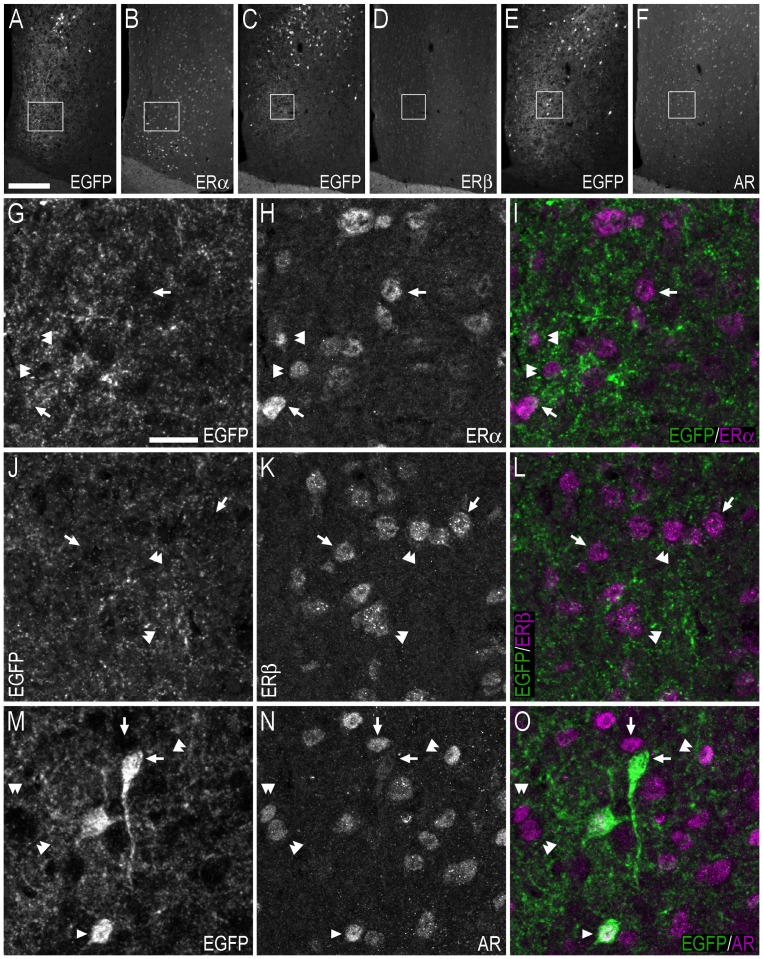
Double-immunofluorescence photo and confocal micrographs showing the distribution of EGFP-, ERα−, ERβ-, and AR-LI at the level of the medial preoptic nucleus/area.(A, B) Single-channel photomicrographs of double-fluorescence immunohistochemistry, showing EGFP− (A) and ERα-LI (B) (Bregma, −0.22 mm). (C, D) Single-channel photomicrographs of double-fluorescence immunohistochemistry, showing EGFP− (C) and ERβ-LI (D) (Bregma, −0.34 mm). (E, F) Single-channel photomicrographs of double-fluorescence immunohistochemistry, showing EGFP− (E) and AR-LI (F) (Bregma, −0.10 mm). (G–I) Single-channel confocal micrographs of double-immunofluorescence (I), displaying EGFP− (G), and ERα-LI (H). The confocal micrographs in (G–I) are magnified views from the white squares shown in (A) and (B). (J–L) Single-channel confocal micrographs of double-immunofluorescence (L), displaying EGFP− (J), and ERβ-LI (K). Confocal micrographs in (J–L) are magnified views of the white squares shown in (C) and (D). (M–O) Single-channel confocal micrographs of double-immunofluorescence (O), displaying EGFP− (M), and AR-LI (N). Confocal micrographs in (M–O) are magnified views of the white squares shown in (E) and (F). In G–O, arrows point to single labelled cell bodies, arrowheads point to double-labelled cell bodies, and double arrowheads point to apparent contacts or close anatomical association between EGFP-ir nerve fibres and single-labelled ERα− (I), ERβ- (L) or AR-ir (O) cell bodies. Scale bars: A = 200 µm, applies A–F; G = 20 µm, applies G–O.